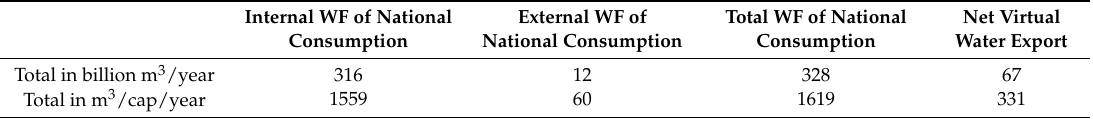
Table 2. Internal, external and total water footprint (WF) of national consumption and virtual water trade in the period 1997–2012 in